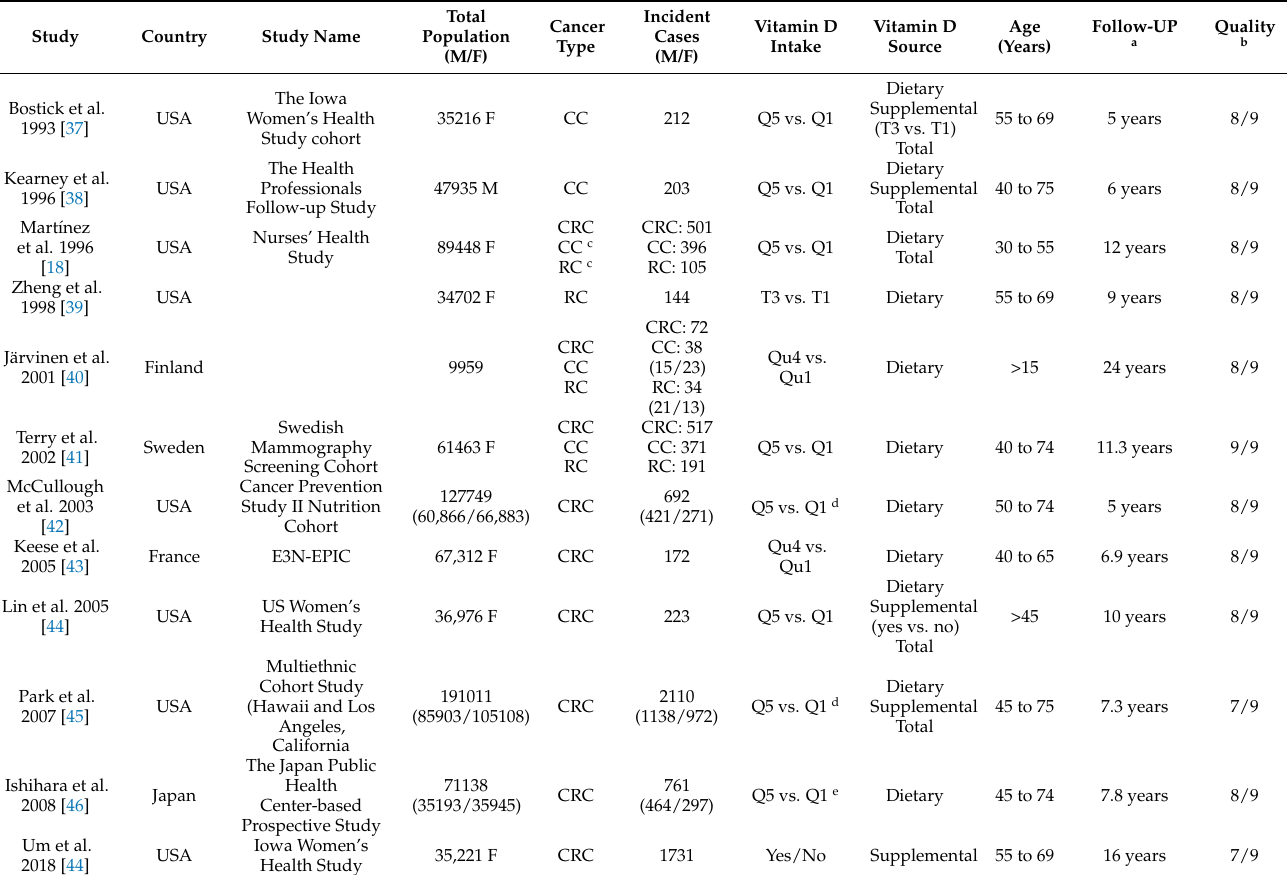
Table 2. Characteristics of prospective studies included in the systematic review and